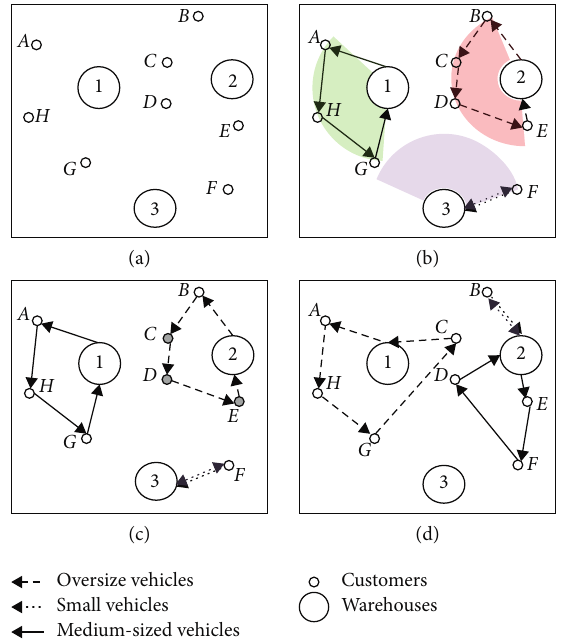
Figure 4: Adaptive neighborhood search process of evolutionary algorithm.